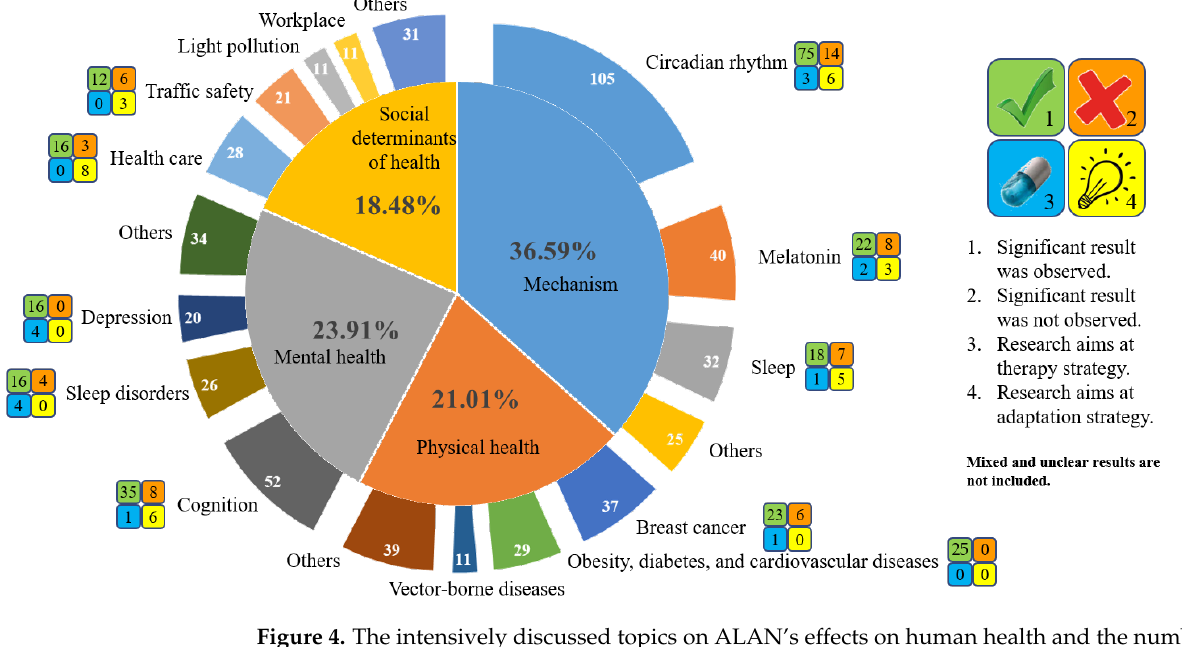
Figure 4. The intensively discussed topics on ALAN’s effects on human health and the number of relevant research articles. The symbol following each research topic is explained by the legend on the